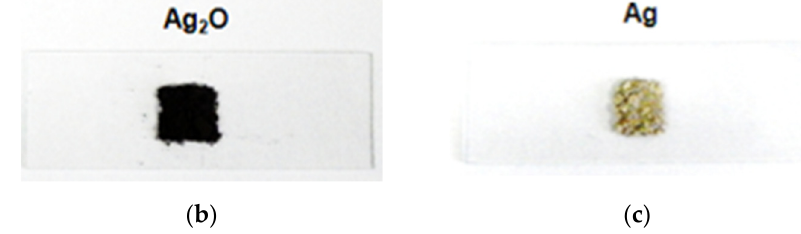
Figure 1. Images of as–received AgNO 3 ( a ); precipitated from Equation (1) Ag 2 O ( b ); and precipitated from Equation (2) Ag ( c ).